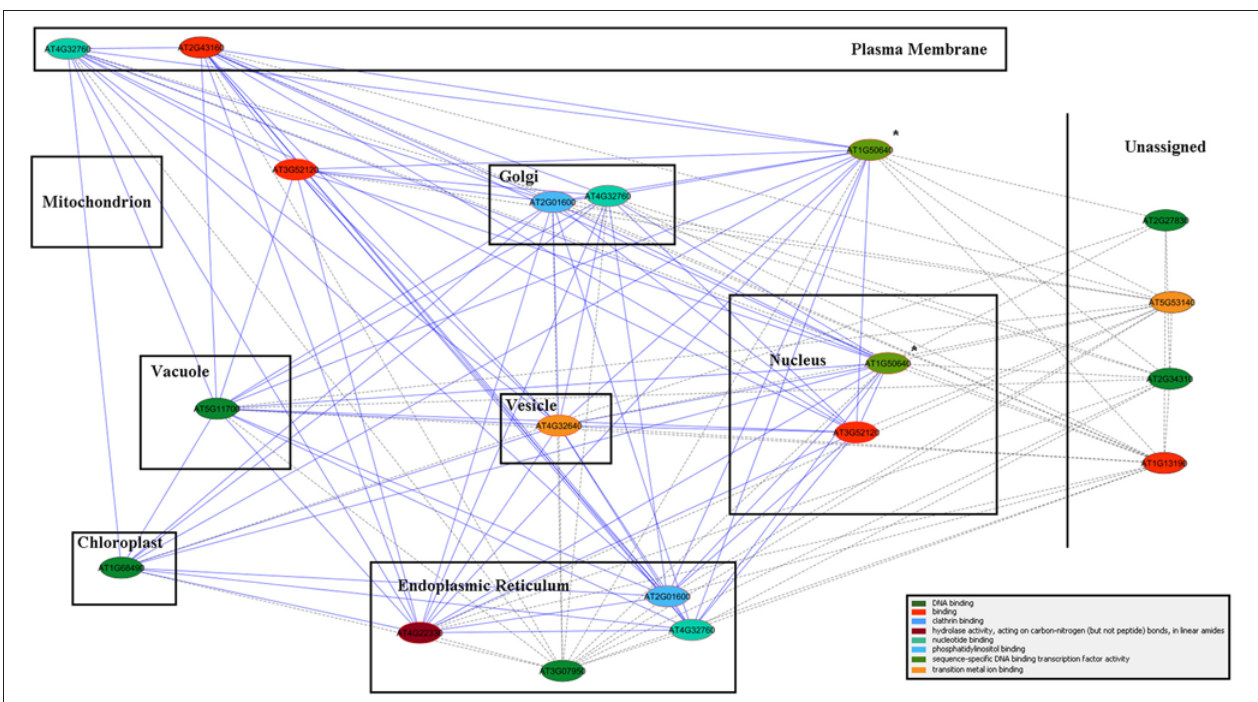
annotations provided by Mosaic, cellular component assignments, as provided directly by GO, were drawn in place of the default Mosaic background image. The query gene is indicated by the “ ∗ ” symbol, and genes with multiple cellular component annotations appear multiple times in the